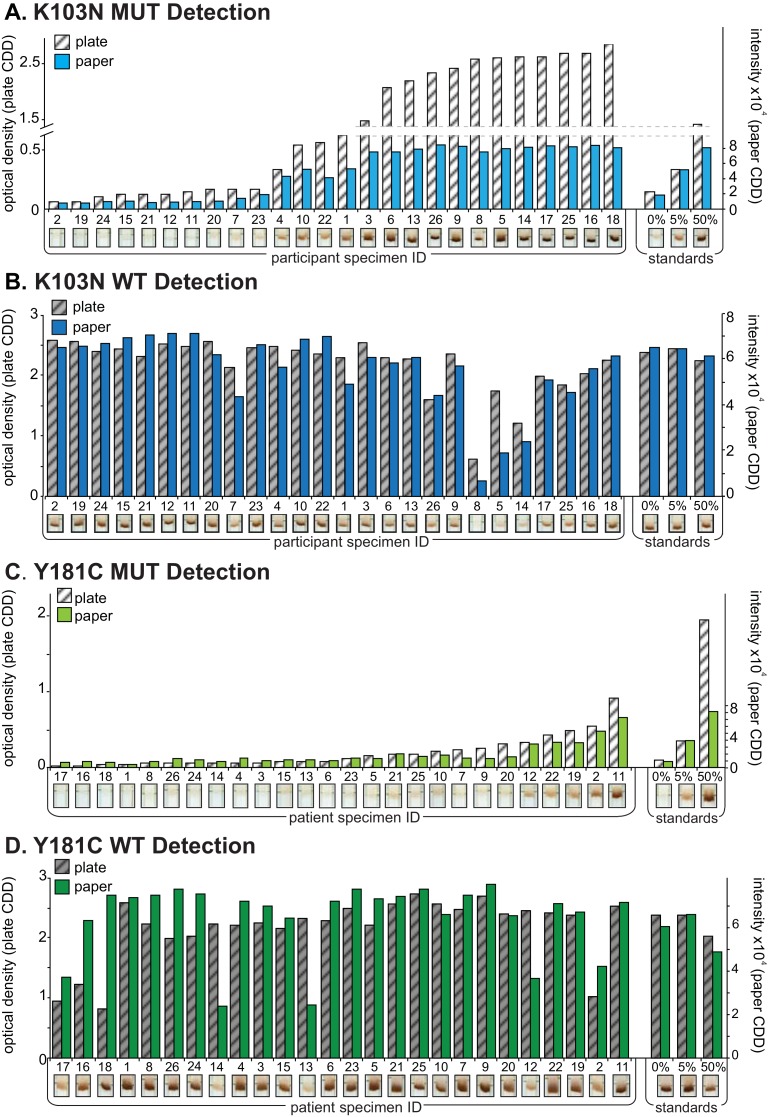
Analysis of clinical specimens and plasmid standards by paper capture, denaturation, and detection (CDD) and plate CDD for mutations K103N and Y181C.Panels A and C show mutant (MUT) detection, and Panels B and D show wild-type (WT) detection. Sample optical density (OD) minus negative control OD (left y axis) for each specimen is shown in white/gray by rank along the x axis, from the lowest MUT OD, followed by the plasmid standards (0%, 5%, 50% MUT) performed in duplicate. Spot intensity minus background intensity (right y axis) for each specimen is shown in blue and green bars followed by the plasmid standards (0%, 5%, 50% MUT) performed in triplicate. Scanned images of the paper CDD detection strip are shown below each specimen’s signal data.